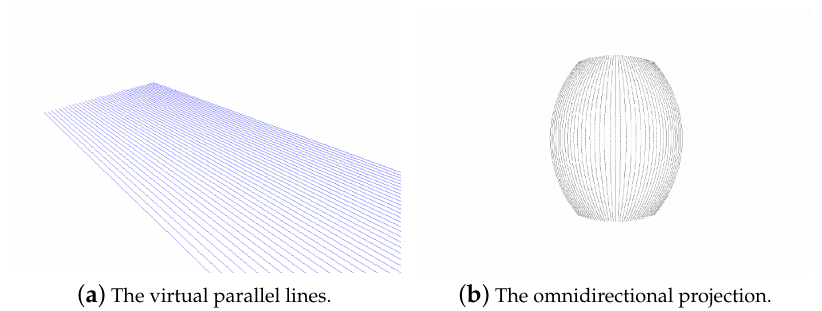
Figure 5. The parallel lines generated using the Cartesian coordinate system and captured by an omnidirectional